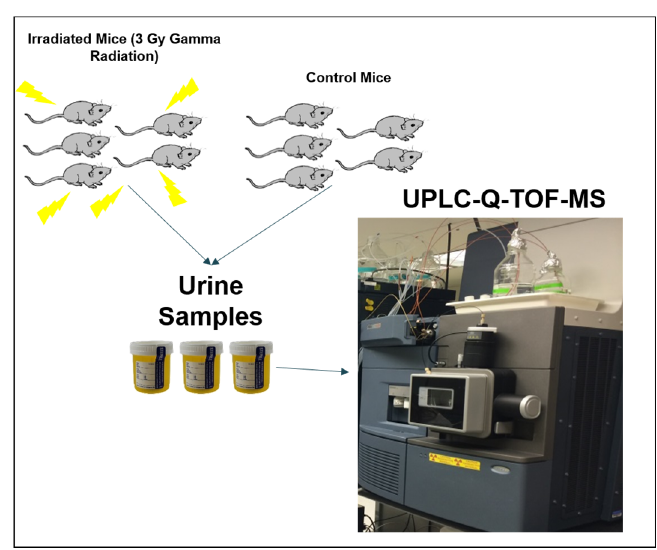
Figure 1. Study Design Schema.